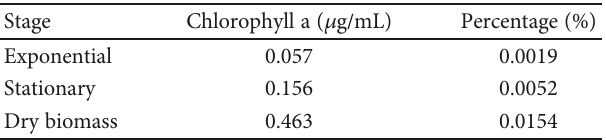
Table 1: Chlorophyll quanti fi cation for di ff erent biomass growing